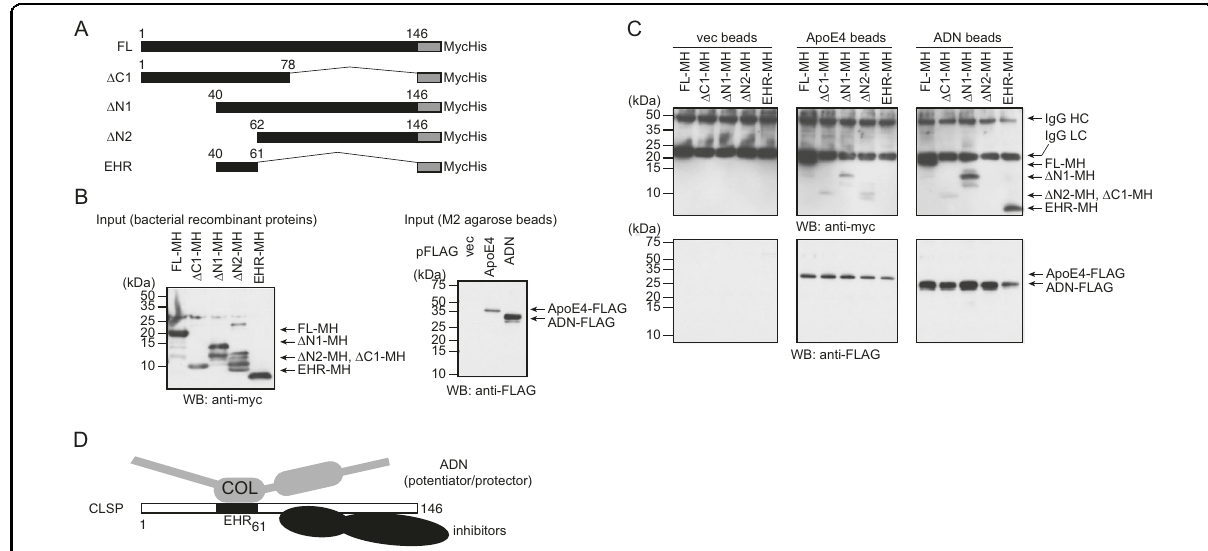
Fig. 3 Apolipoprotein E4 and adiponectin bind to different sites of CLSP. a A schematic illustration of deletion mutants of CLSP. b Puri fi ed recombinant C-terminally MycHis-tagged CLSP (FL-MH) or CLSP deletion mutants that were produced in bacteria and C-terminally FLAG-tagged ApoE4 and adiponectin (ADN), which were puri fi ed from F11 neurohybrid cells by immunoprecipitation with FLAG antibody (M2 agarose beads), were immunoblotted using myc and FLAG antibodies as inputs for pull-down analysis shown in c . c The ApoE4-FLAG and ADN-FLAG immunoprecipitates were mixed with puri fi ed recombinant CLSP-MycHis (FL-MH) or C-terminally MycHis-tagged CLSP deletion mutants and incubated at 4 °C overnight. The pulled-down precipitates were then immunoblotted using myc and FLAG antibodies. d A schematic illustration of the interaction of CLSP, adiponectin, and a CLSP